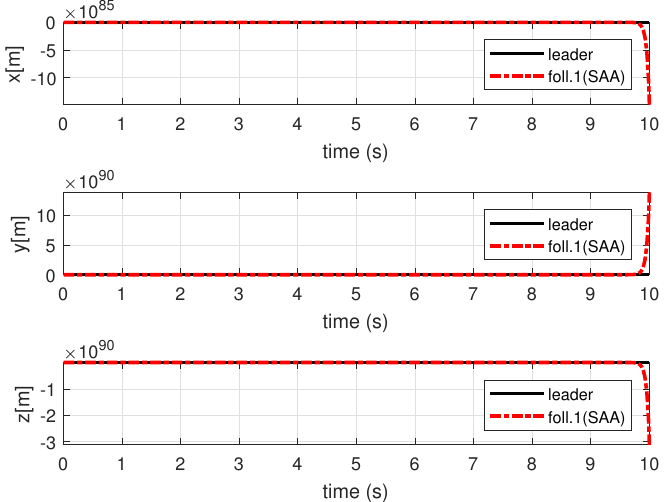
Figure 19. The results of the comparison simulation for the formation control of the first follower quadrotors about the 6 π circular trajectory: the solid line indicates the results of the leader quadrotor; the red dashed line is the result of the backstepping-based formation control with